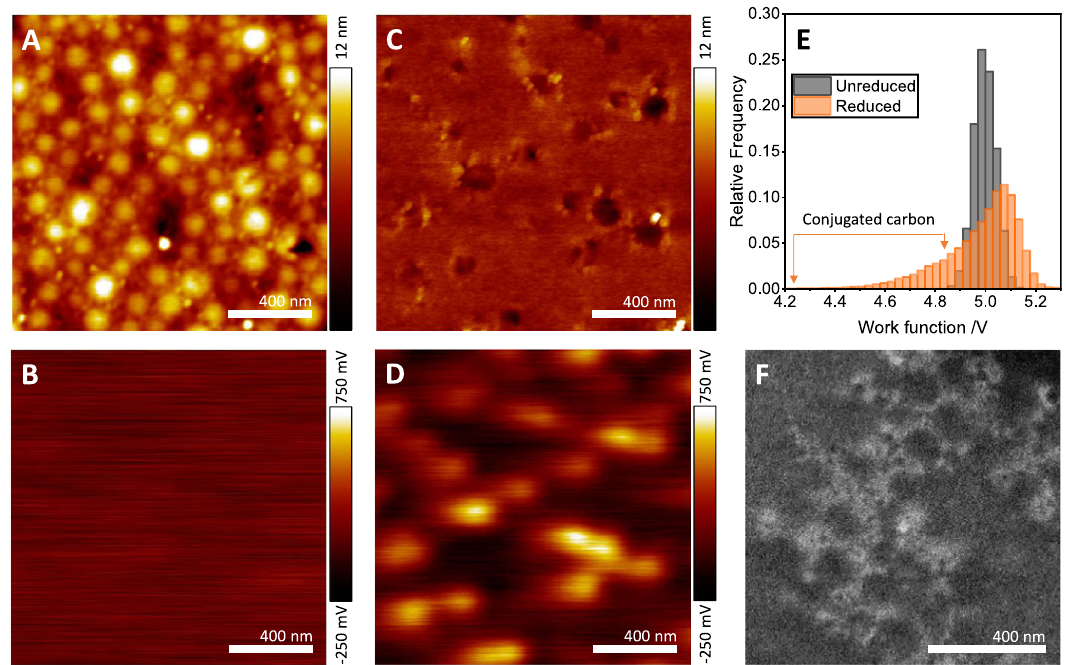
Fig. 3 | Nanoscale topographic and electronic characterisation. Kelvin probe force microscopy (KPFM) data for the topography ( A ) and contact potential dif- ference ( B ) of an unreduced composite; panels C , D show the corresponding measurementsafterreductionoftheGOinsitu. E Modi fi cationoftheworkfunction